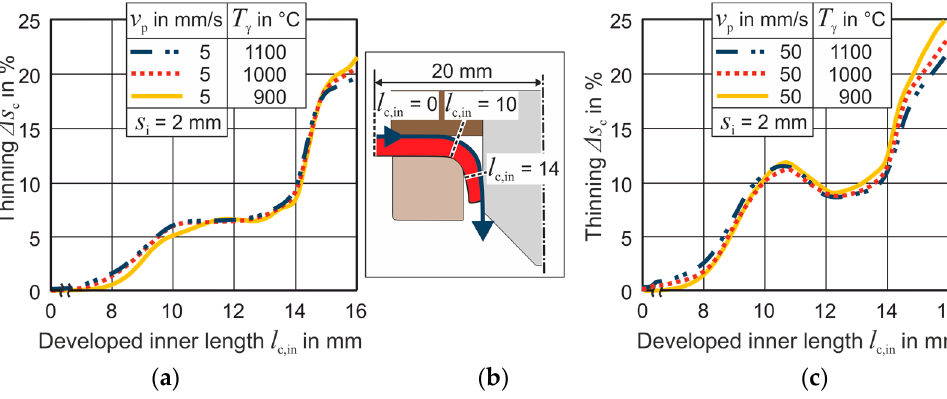
Figure 6. ( a ) Effect of the austenitizing temperature T γ on thinning of the collar ∆ s c with a constant punch speed v p of 5 mm/s; ( b ) Definition of the developed inner length l c,in ; ( c ) Effect of austenitizing temperature T γ on thinning of the collar ∆ s c with a constant punch speed v p of 50 mm/s.